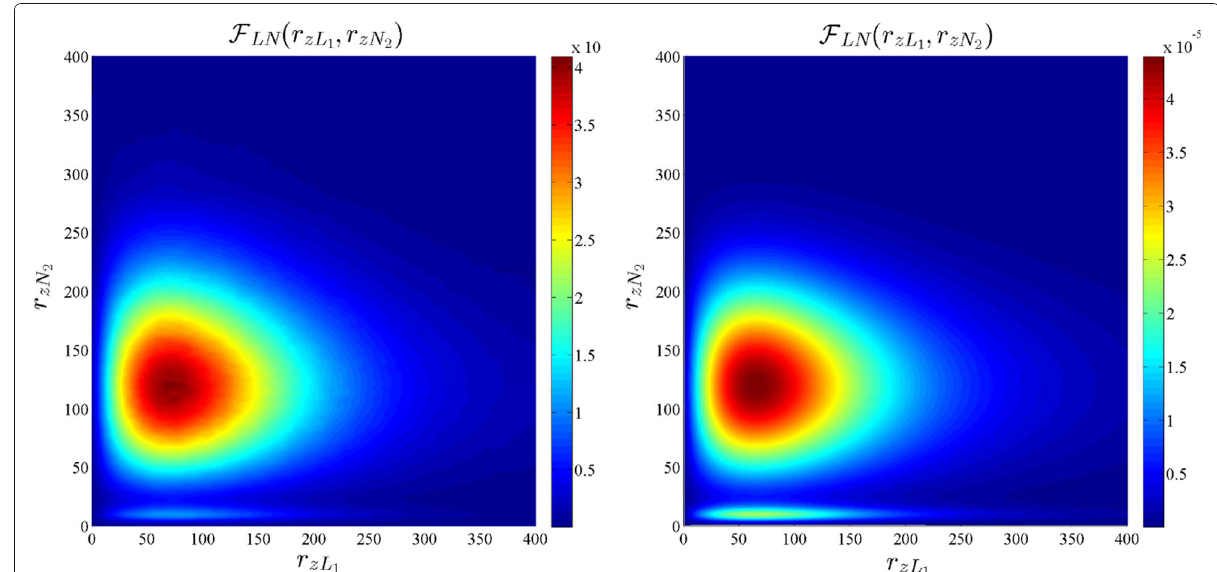
Fig. 5 Joint densities of R zL 1 and R zN 2 for the actual PPP model (left) and the independence assumption (right). R zL 1 and R zN 2 are the distances of LOS users to their respective BSs in two neighboring cells